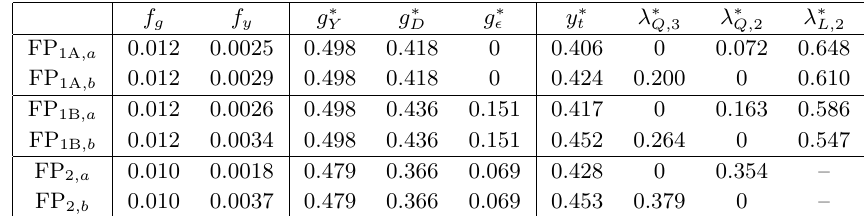
Table 2 . Trans-Planckian fixed-point values for the gauge and Yukawa couplings and the corre- sponding gravity parameters f